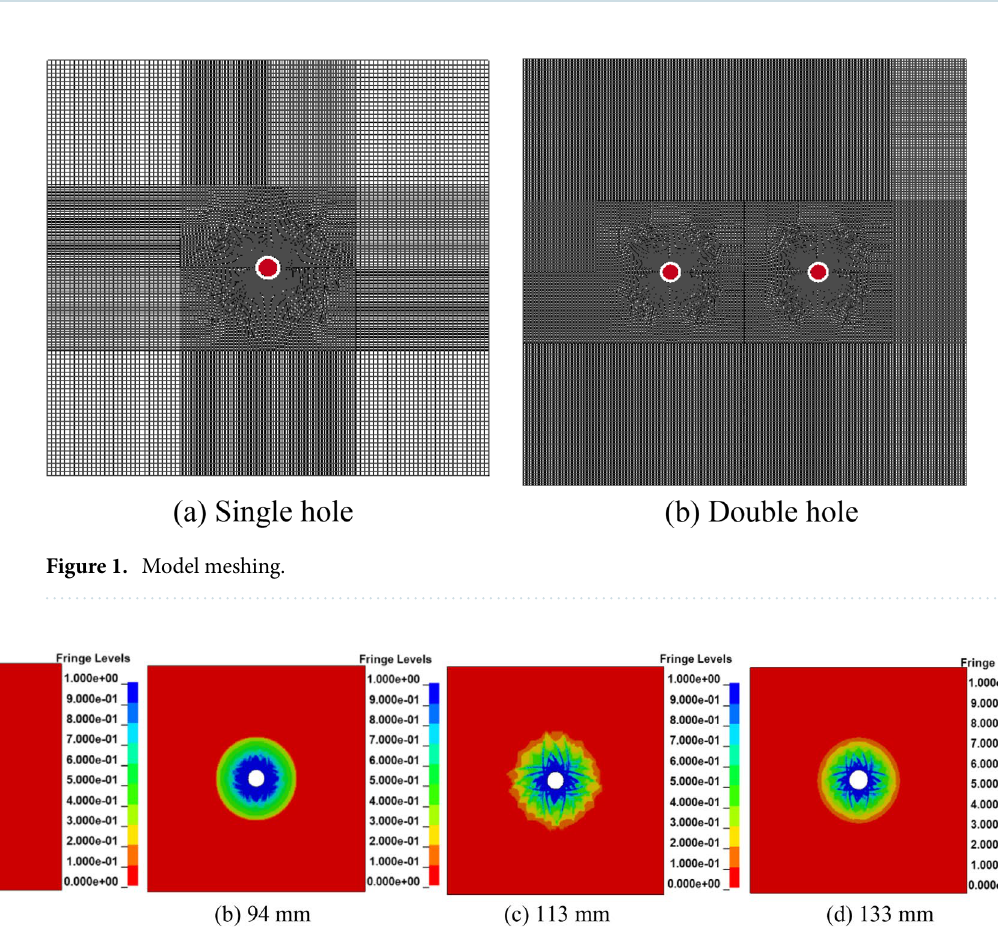
Figure 2. Damage distribution cloud map of coal with different pore